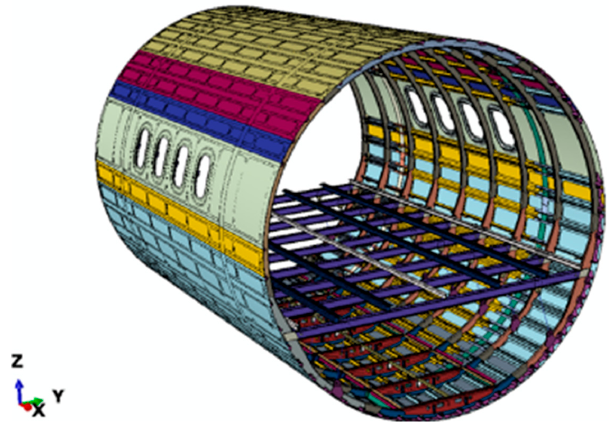
Figure 2. Whole fuselage section.